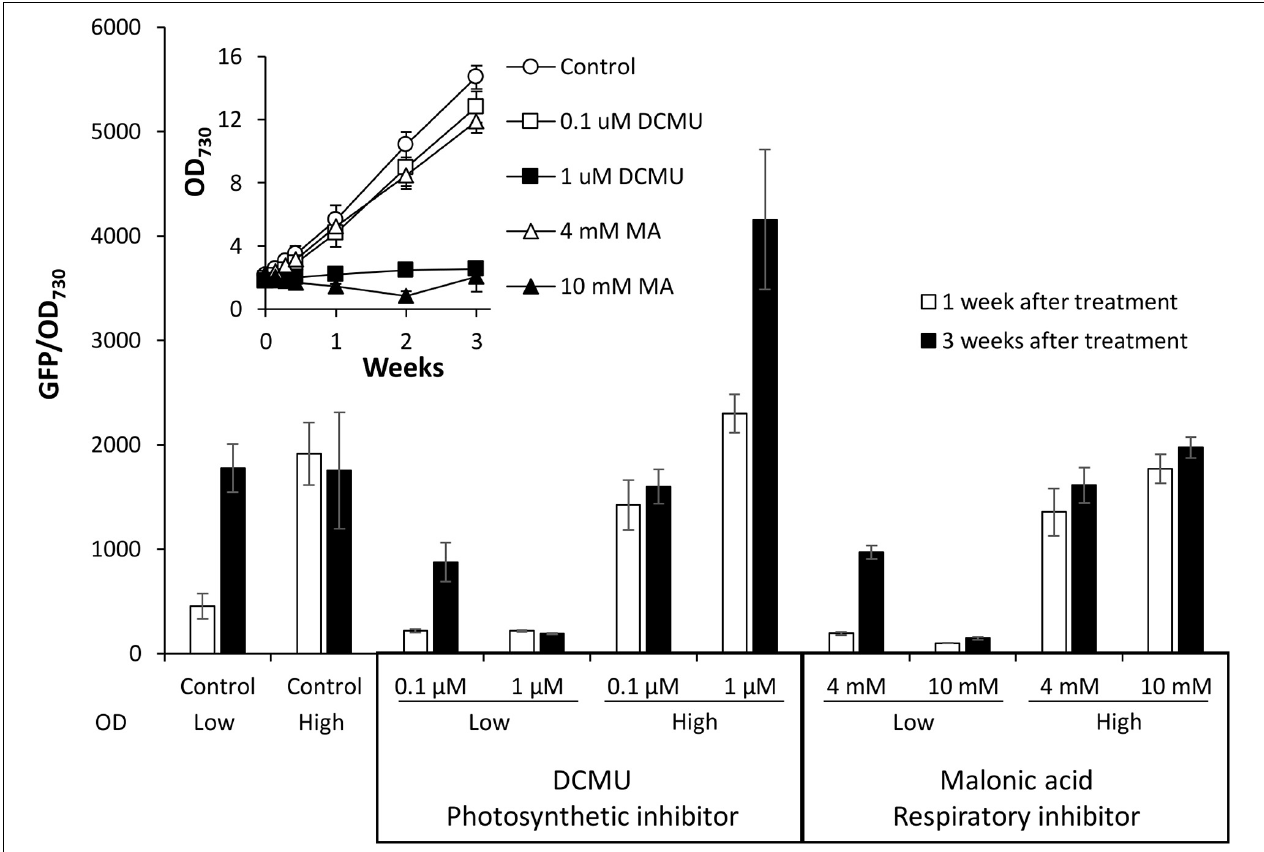
FIGURE 9 | The effect of electron transport inhibition on PndbA600 activity. PndbA600 activity (GFP fluorescence normalised to OD 730 ) in Synechococcus PndbA600:GFP 1 week (white bars) and 3 weeks (black bars) after treatment with DCMU or malonic acid at the given concentration. OD indicates low (OD < 5) or high (OD < 12) culture density at the start of treatment. Control are untreated cultures. Data are means ± S.E.M. of at least three independent cultures. Inset shows culture growth starting from low OD in the different